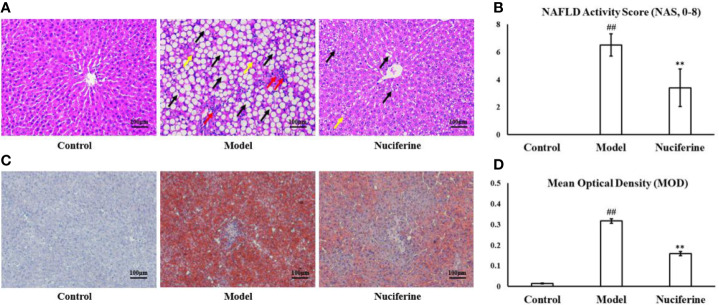
Nuciferine treatment improved the hepatic steatosis. (A, B) H&E staining revealed enlarged hepatocytes in the experimental model group and the nuciferine-treated rats showed only moderate steatosis and ballooning in the liver as well as a lower NAS. Black arrows indicate the steatosis of hepatocytes, red arrows indicate lobular inflammation, and yellow arrows indicate hepatocyte ballooning (200× magnification). (C, D) Oil Red O staining indicated that the lipid-loaded hepatocytes and the MOD of staining extents were decreased in the nuciferine-treated rats as compared to the experimental model group (200× magnification). Control, experimental model, and nuciferine-treated (n = 10 per group) groups. ##p < 0.01 as compared to the control group; **p < 0.01 as compared to the experimental model group.